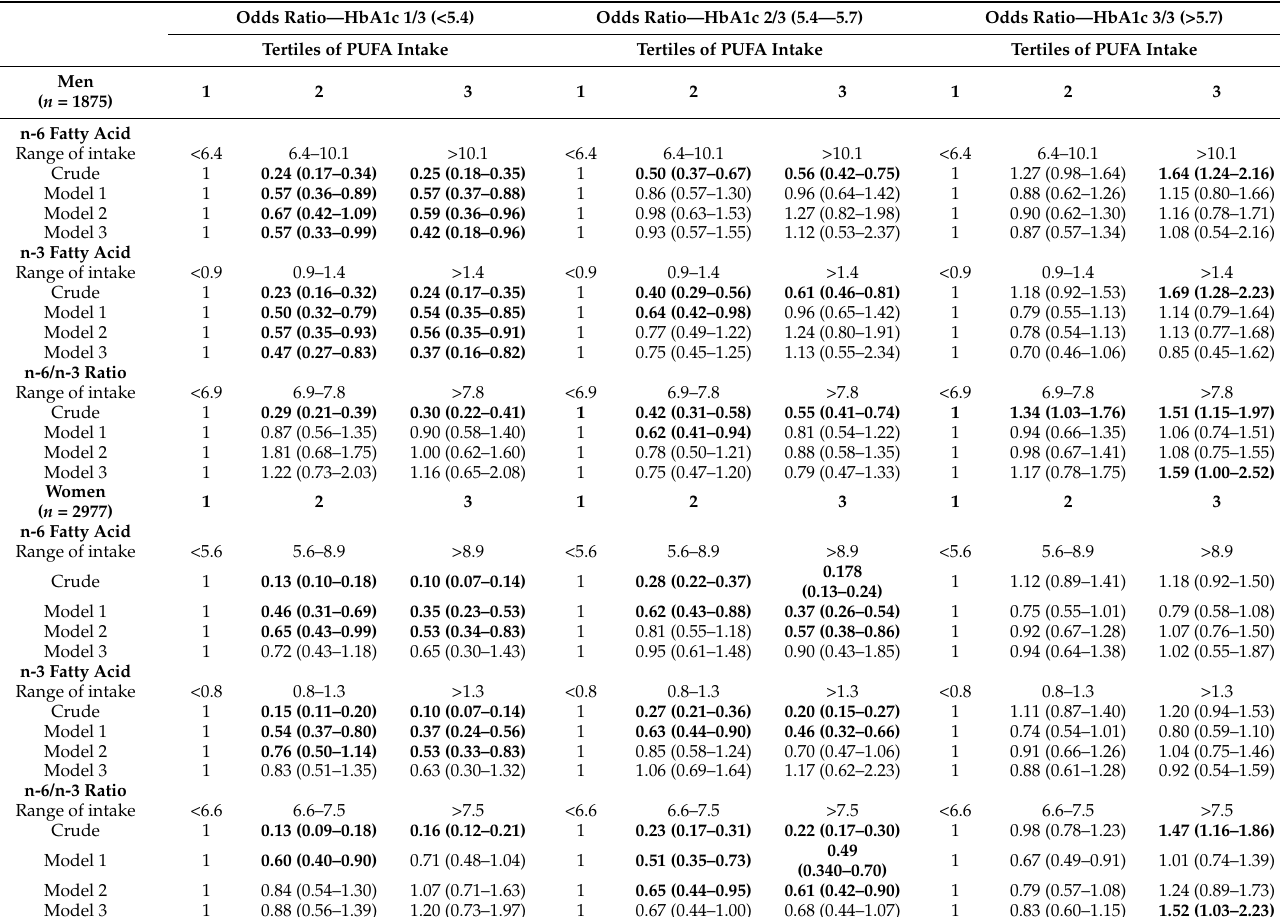
Table 3. Multivariate-adjusted odds ratios and 95% confidence intervals for the interactions between MetS and HbA1c groups according to n-3 and n-6 fatty acid intakes and gender for Korean